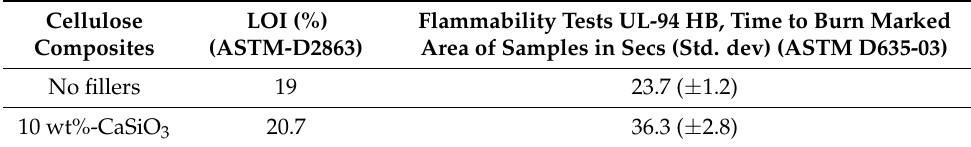
Table 1. Effect of the addition of CaSiO 3 on the LOI and FR properties of